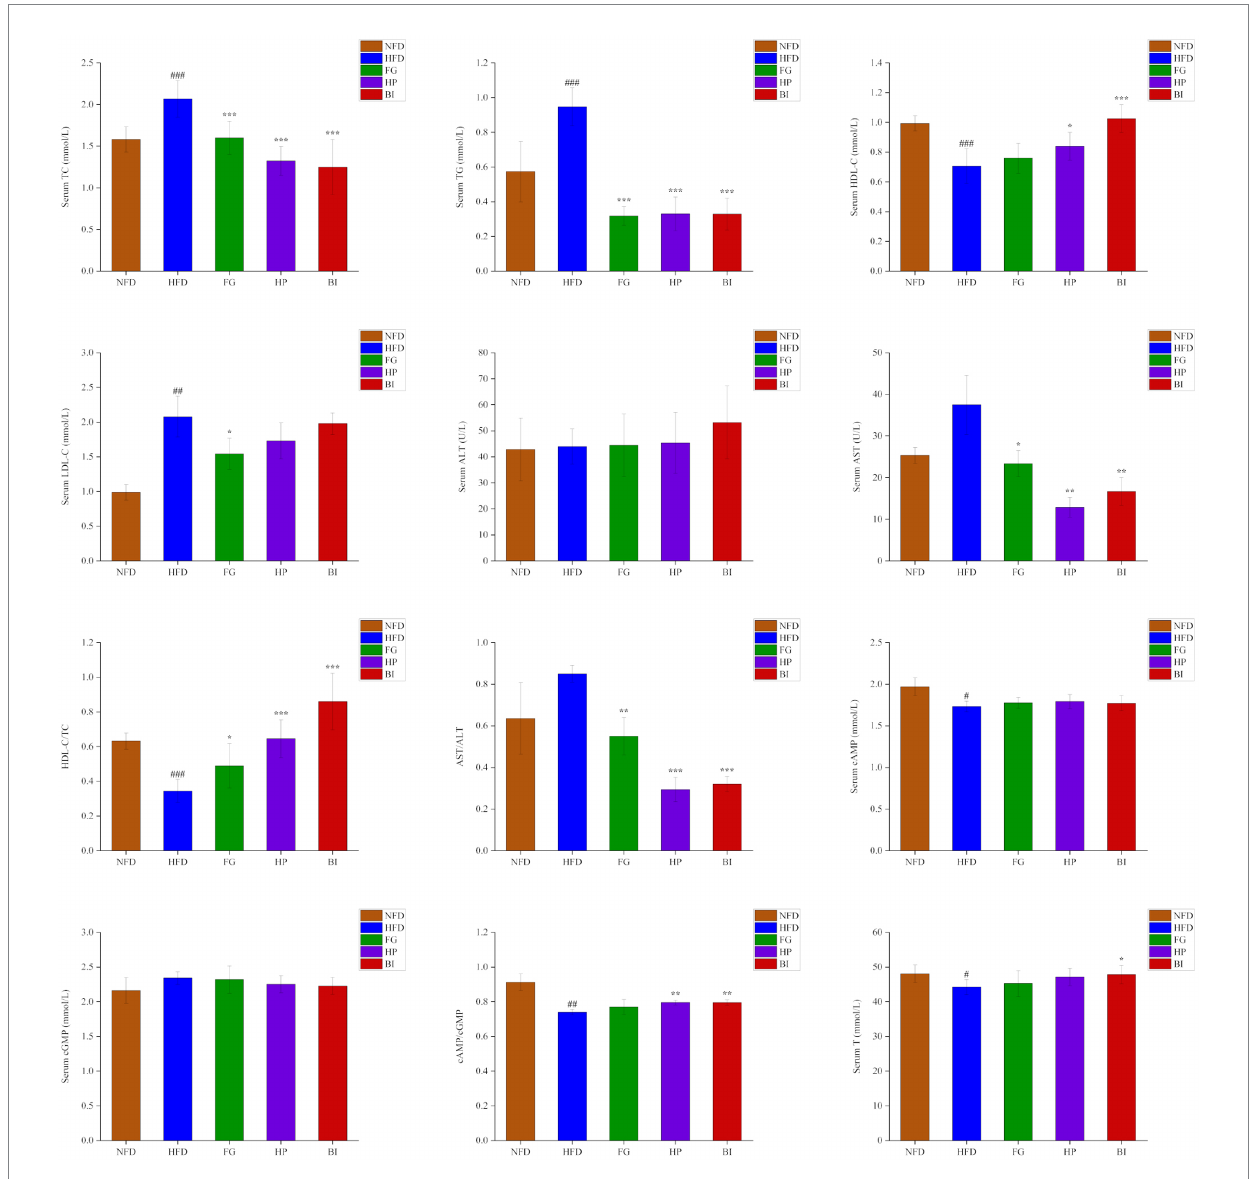
FIGURE 2 Effects of FG, HP, and BI treatment on serum biochemical indicators in HFD-fed rats. The Serum TC, Serum TG, Serum HDL-C, Serum LDL-C, Serum ALT, Serum AST, HDL-C/TC, AST/ALT, Serum cAMP, Serum cGMP, cAMP/cGMP, and Serum T levels were shown. Values were expressed as mean ± SD in each group ( n = 6). Significantly different from NFD group, # p < 0.05, ## p < 0.01, ### p < 0.001. Significantly different from HFD group, * p < 0.05, ** p < 0.01, *** p <